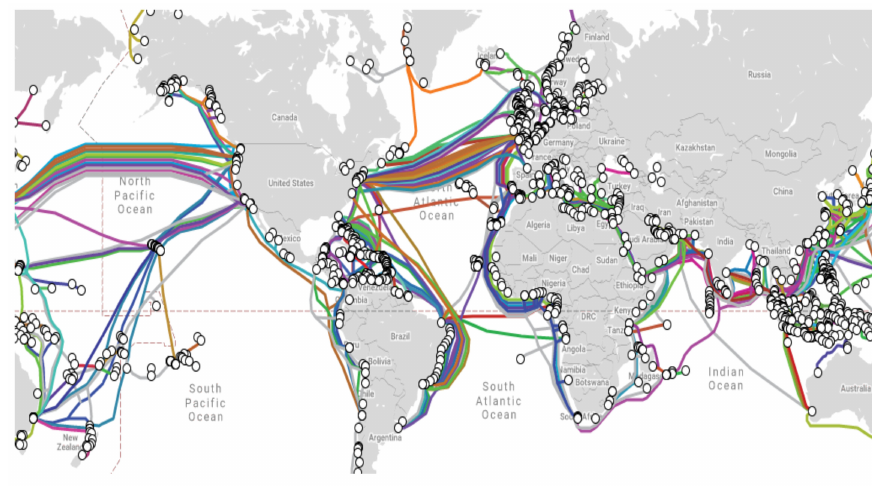
Figure 2. Current status of undersea cables around the world. Reprinted from ref.